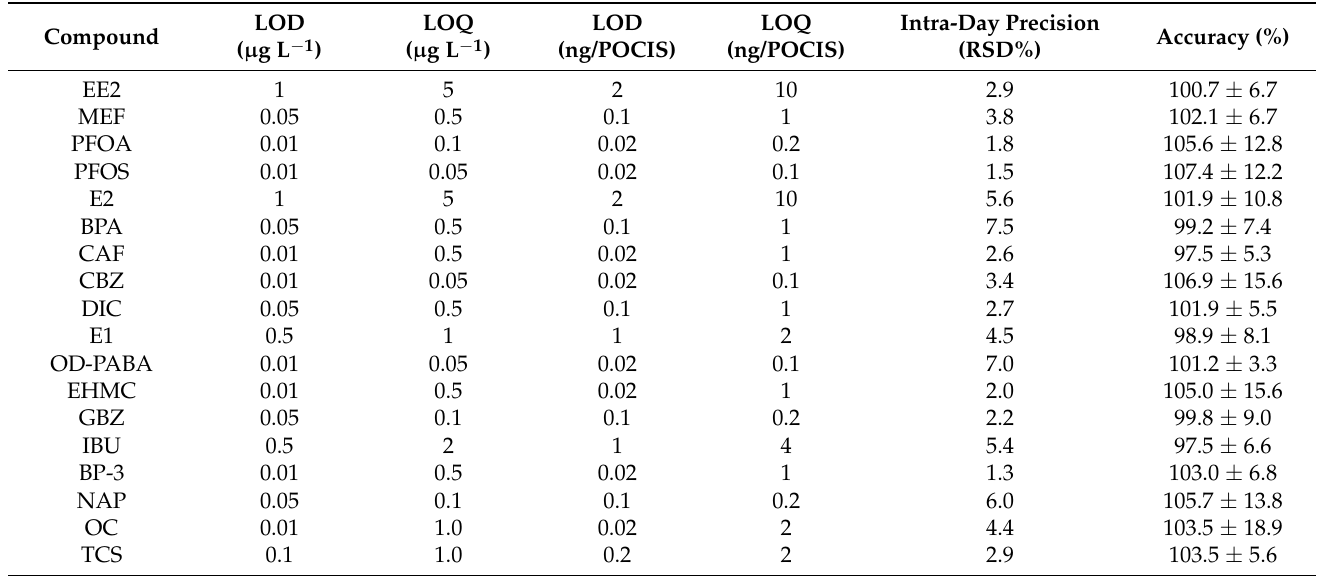
Table 1. Limits of detection and quantitation of the monitored emerging pollutants in solution ( µ g L − 1 ) and in the POCIS sampler (ng/POCIS), intra-day precision and